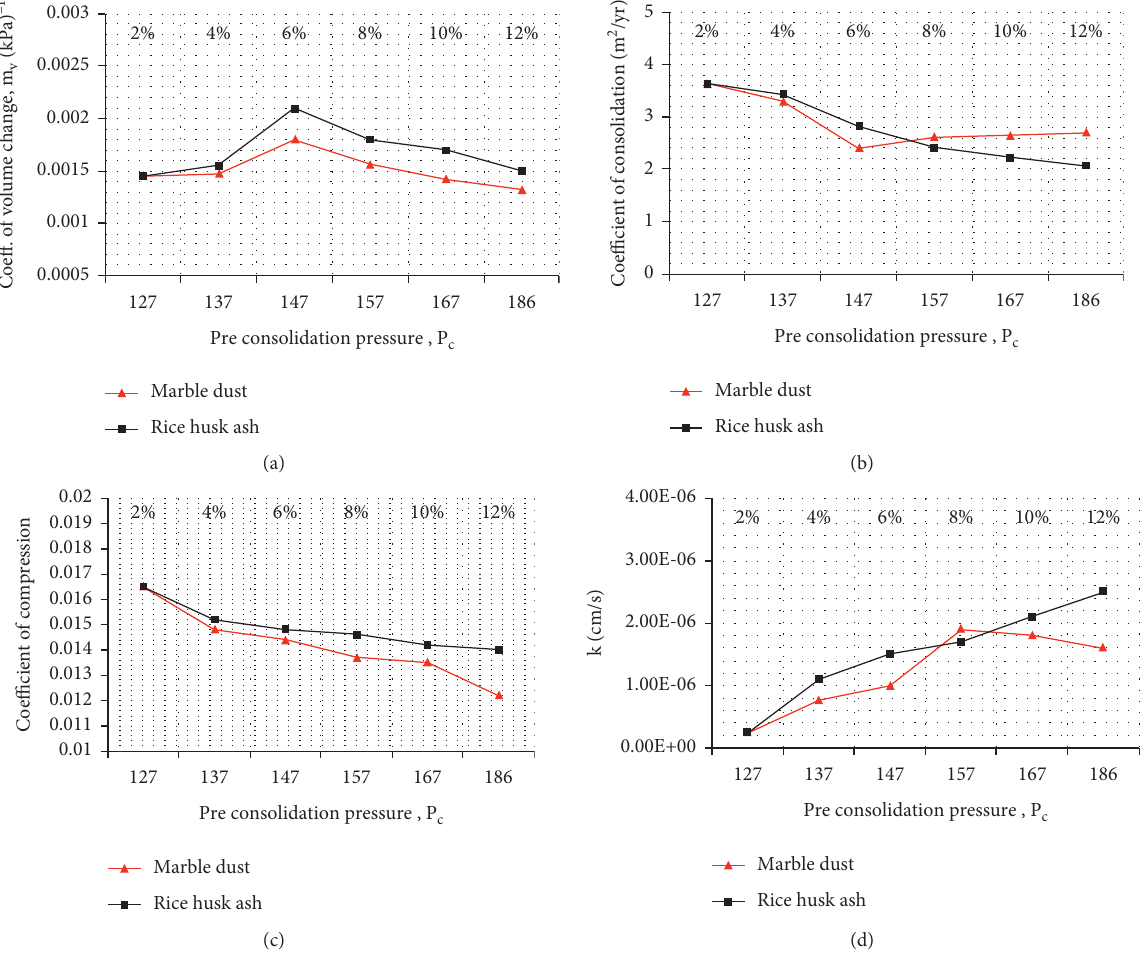
Figure 11: (a) The coefficient of volume change m c v . (b) The coefficient of consolidation v . (c) The coefficient compression C c . (d) The coefficient of hydraulic conductivity k versus preconsolidation pressure for soil blended with marble dust/rice husk